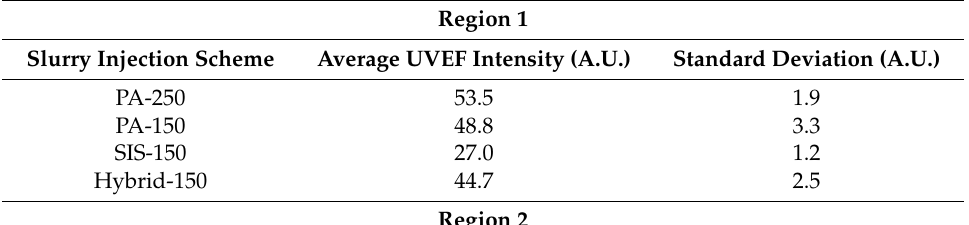
Table 1. Summary of ultraviolet enhanced fluorescence (UVEF) images analysis.